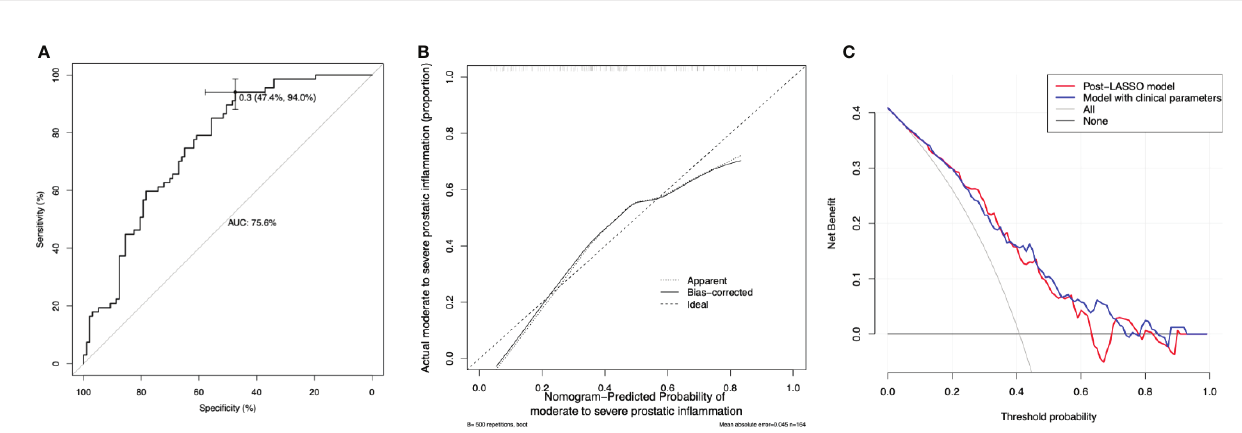
FIGURE 5 | Model discrimination, calibration, and decision curve analysis. (A) Receiver operating characteristic curves (ROCs) for the diagnostic models. AUC = the area under the ROC curve. The laboratory model had an AUC of 0.756 (95% con fi dence interval 0.684 – 0.829) the optimal cutoff is 0.3, with the sensitivity of 0.94 and speci fi city of 0.47. (B) Calibration curve of the post-LASSO diagnostic nomogram accompanied by the bootstrap approach (the number of bootstrap repetitions B = 500). Calibration curve depicts the calibration of in terms of the agreement between the predicted risks of prostatic in fl ammation and observed prostatic in fl ammation. The y-axis represents the actual prostatic in fl ammation. The x-axis represents the predicted prostatic in fl ammation. The diagonal dashed line represents a perfect prediction by an ideal model. The dotted (apparent) and solid (bootstrap bias corrected) line represents the performance of the nomogram, of which a closer fi t to the diagonal dashed line represents a better prediction. (C) Decision curve analysis for the post-LASSO simpler nomogram and the model supplemented with clinical parameters. The y-axis measures the net bene fi t. The x-axis is the risk threshold probability that changes from 0 to 1. The red line represents the post-LASSO nomogram. The blue line represents the model with clinical parameters. The grey line represents the assumption that all patients have prostatic in fl ammation. The black line represents the assumption that no patients have prostatic in fl ammation. The decision curve analysis yielded a range of thresholds (8 to 63%) at which using the post-LASSO model to diagnose prostatic in fl ammation adds more bene fi t than the treat-all-patients scheme or the treat- none